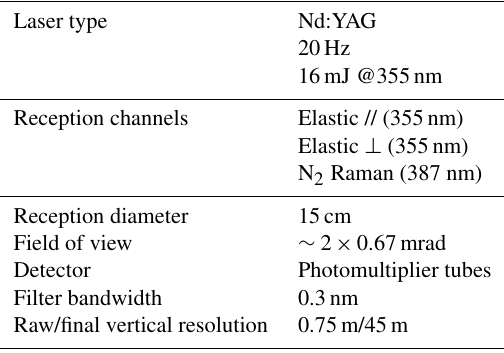
Table 1. Characteristics of LAASURS.